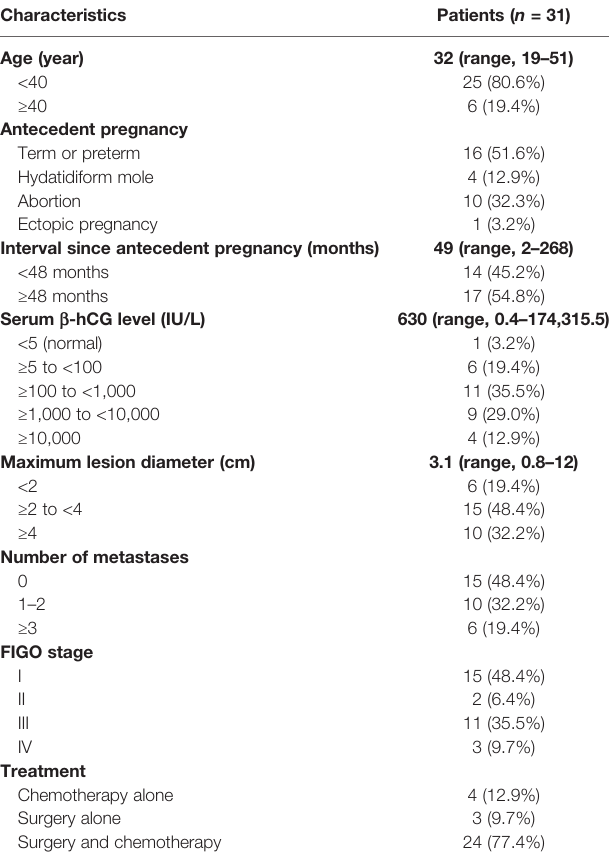
TABLE 1 | Characteristics of the patients at baseline.